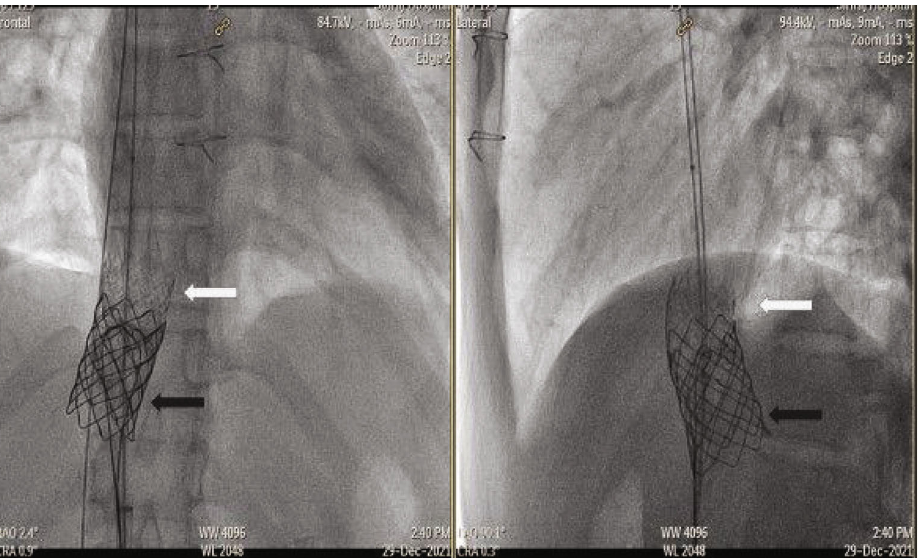
Figure 15: Angiography showing the previously embolized covered stent successfully pulled back inside the primary anchored bare stent. The black arrow and white arrow indicate the position of the bare stent and the covered stent,